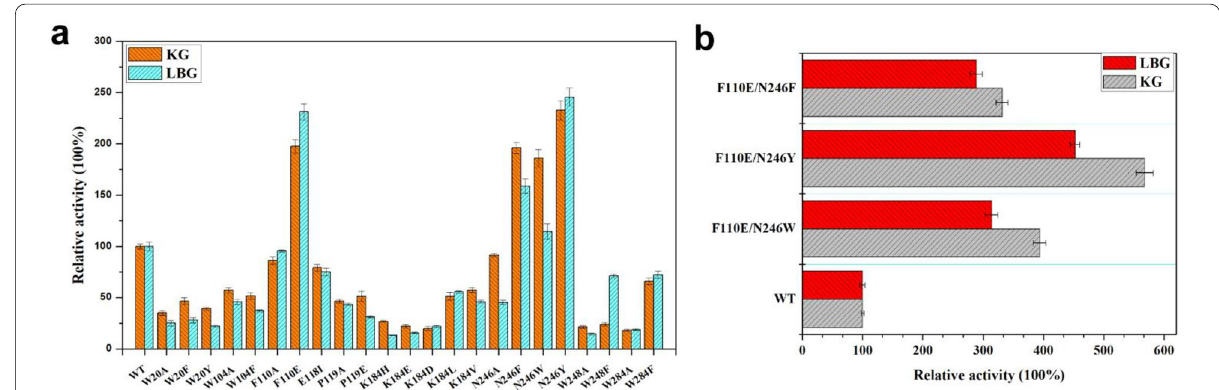
Fig. 5 The catalytic relative activity of PcMan113‑WT, mutants ( a ) and screened double mutants ( b ) towards KG and LBG. The catalytic activity of WT‑PcMan113 against KG and LBG is represented as 100% and the error bars are standard deviations (n